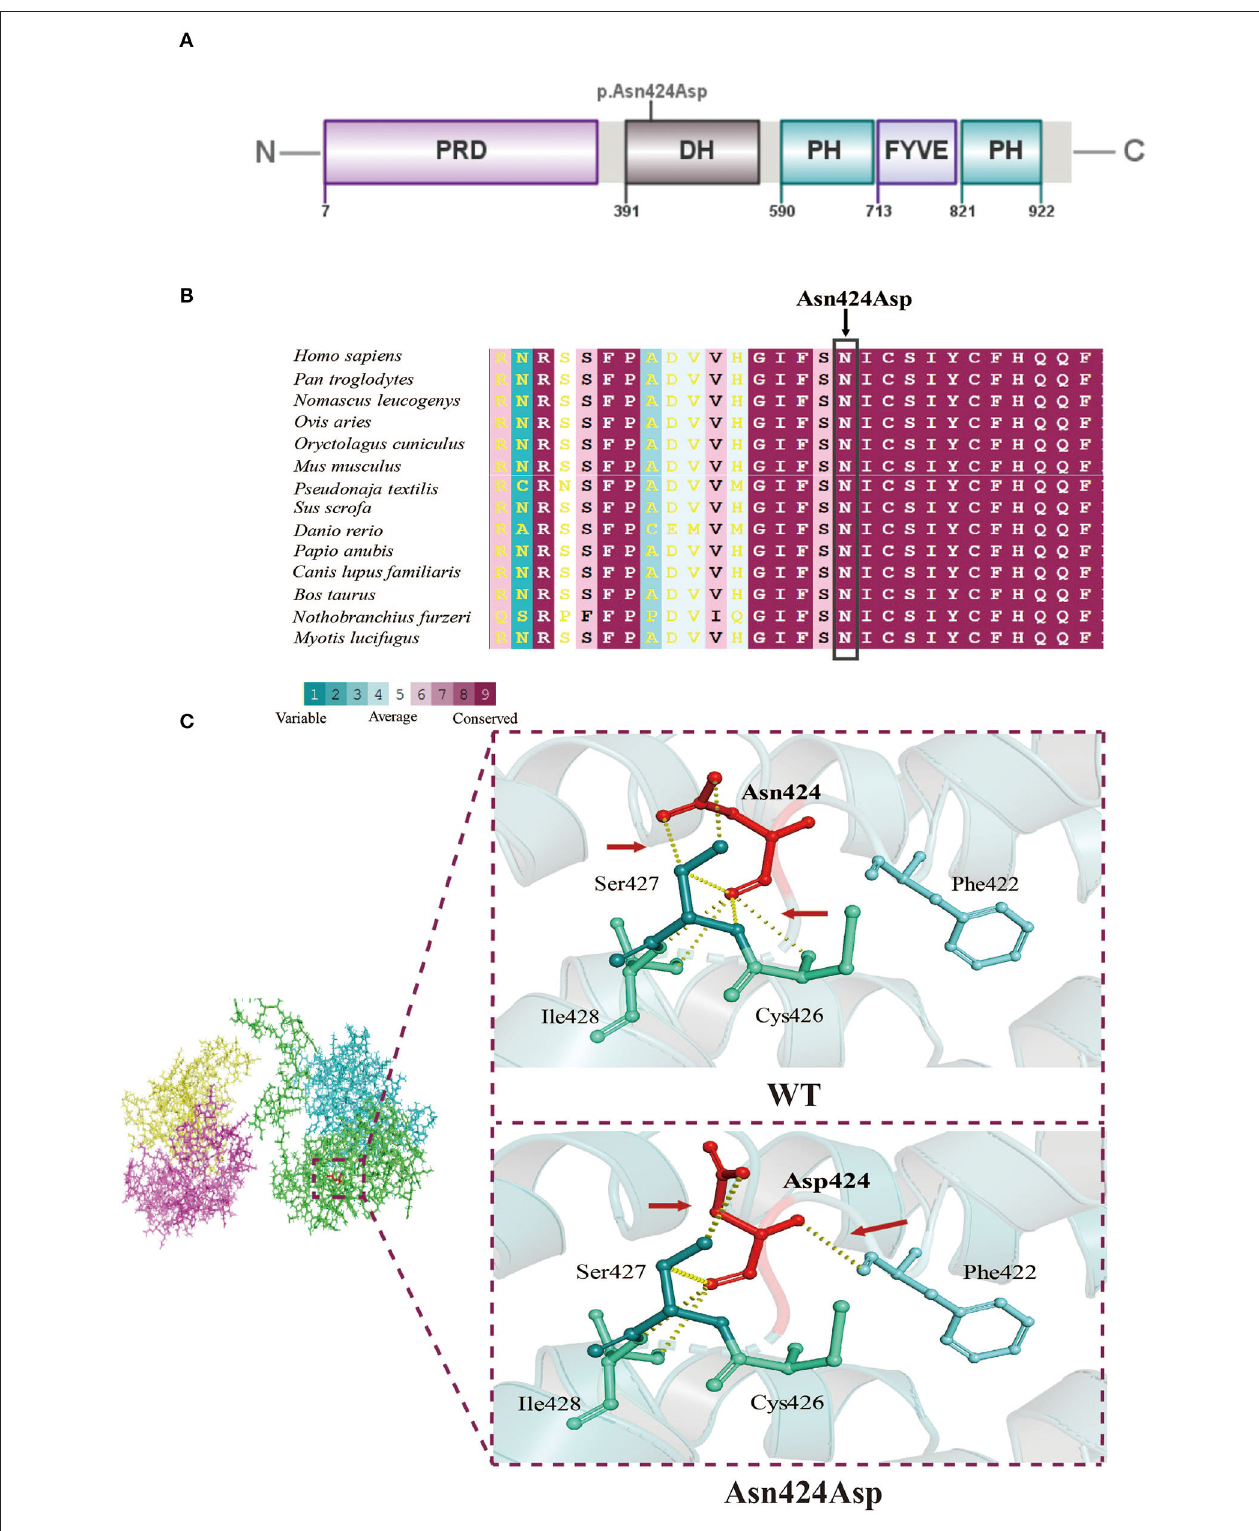
FIGURE 2 | Molecular analysis. (A) A schematic diagram showing the location of the mutation site. (B) Interspecific conservation analysis of the p.Asn424Asp mutation in FGD1, highlighted by the box. (C) Three-dimensional structure model of the local structural changes between wildtype and mutant FGD1 protein, as predicted by Dynamut. Red arrows represent the difference in hydrogen between the wildtype and mutant.